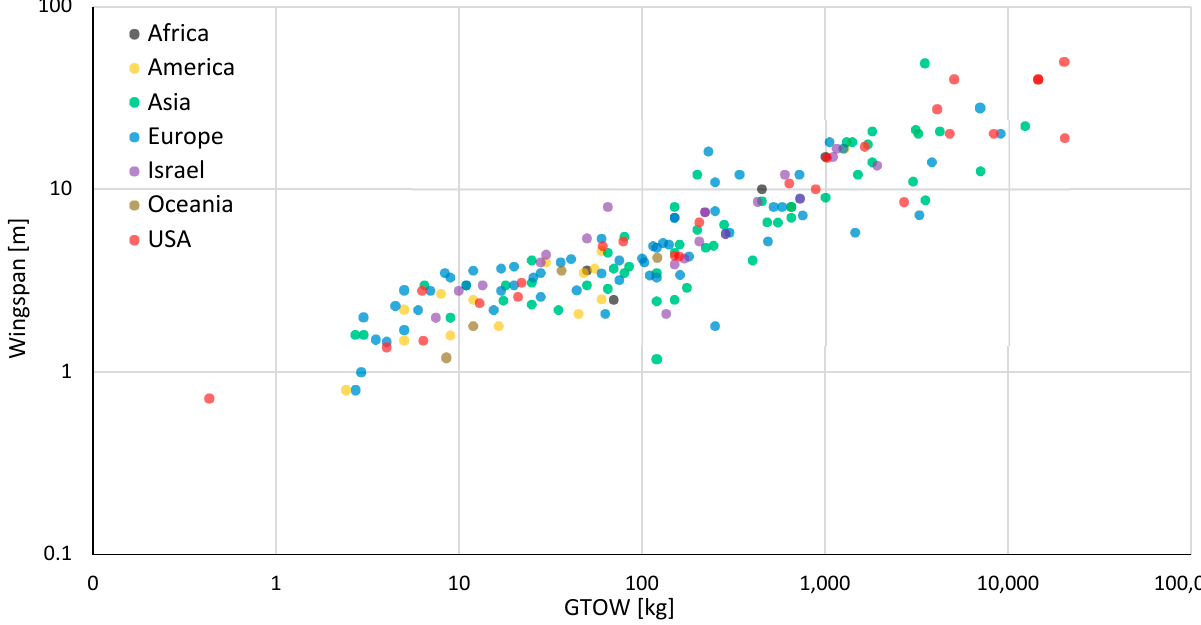
12 of 32 Figure 6. Wingspan as function of GTOW with respect to the NATO classi fi cation. Dark red color is used for the trendline of the entire sample, while the rest of the colors are used for the respective classes and coincide with the bullets color code, as explained in the legend. Table 5. Statistical data regarding the trend fi tt ing for the wingspan vs. GTOW plots. R 2